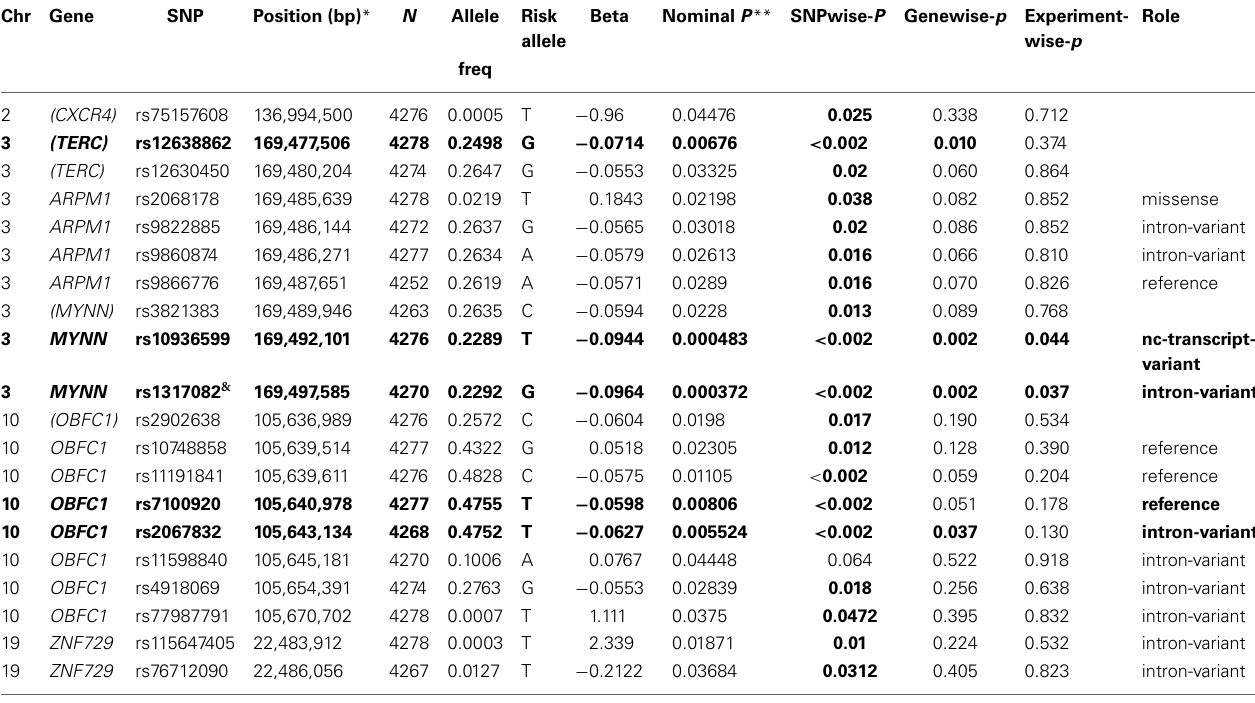
Table 6 | Association in previously reported genes from other studies. Chr